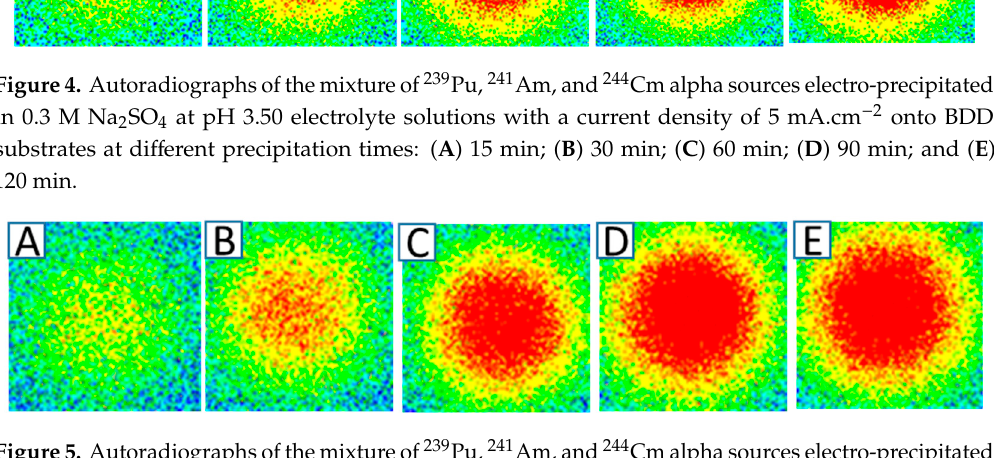
Figure 5. Autoradiographs of the mixture of 239 Pu, 241 Am, and 244 Cm alpha sources electro-precipitated in 0.3 M NaNO 3 at pH 3 electrolyte solutions with a current density of 2.5 mA.cm − 2 onto BDD substrate at different precipitation times: ( A ) 15 min; ( B ) 30 min; ( C ) 60 min; ( D ) 90 min; and ( E ) 120 min.